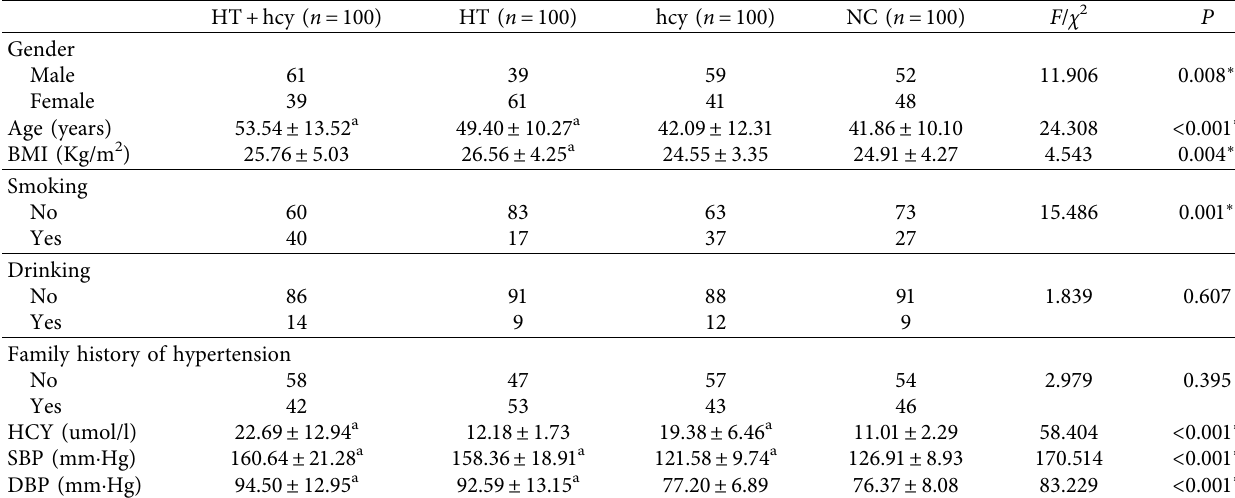
Table 1: Baseline characteristics of the four groups.